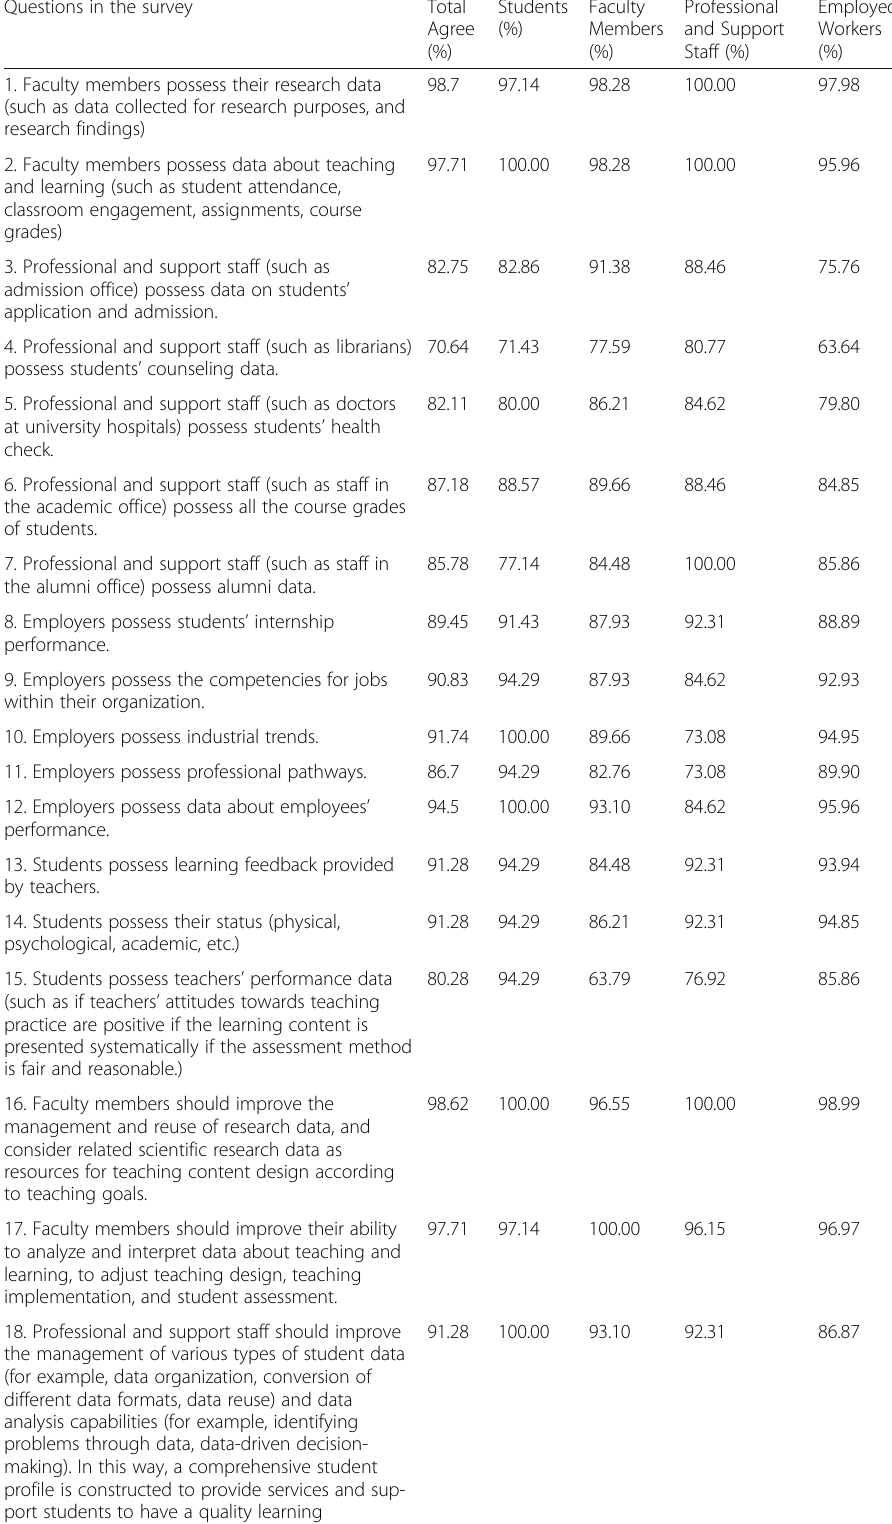
Table 3 A Brief Summary of the Survey Result Questions in the